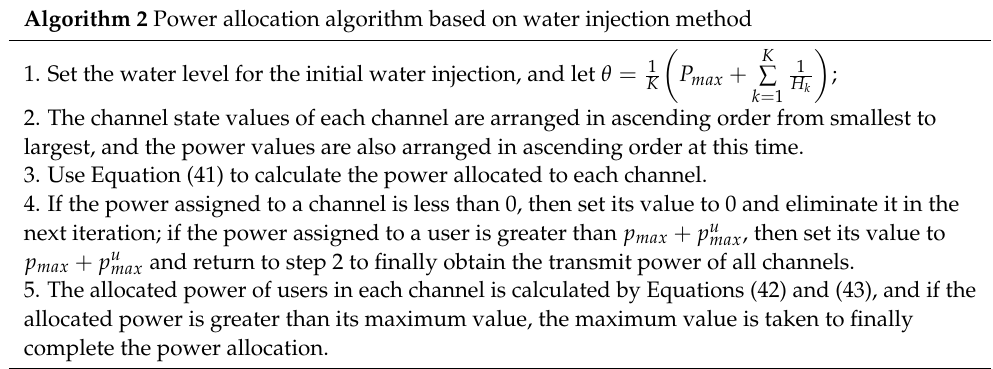
Algorithm 2 Power allocation algorithm based on water injection